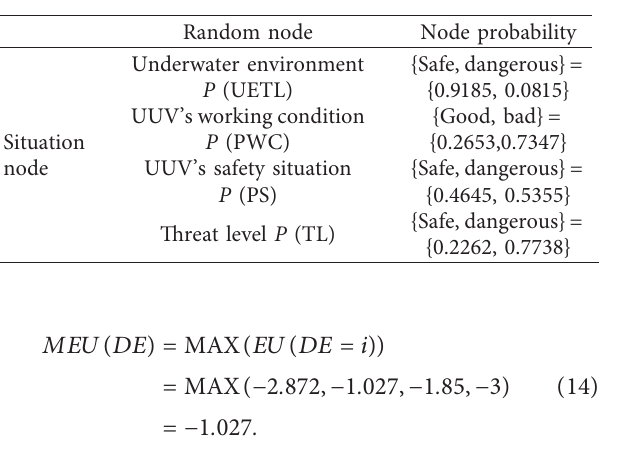
Table 6: Marine environmental situation and working and safety status.